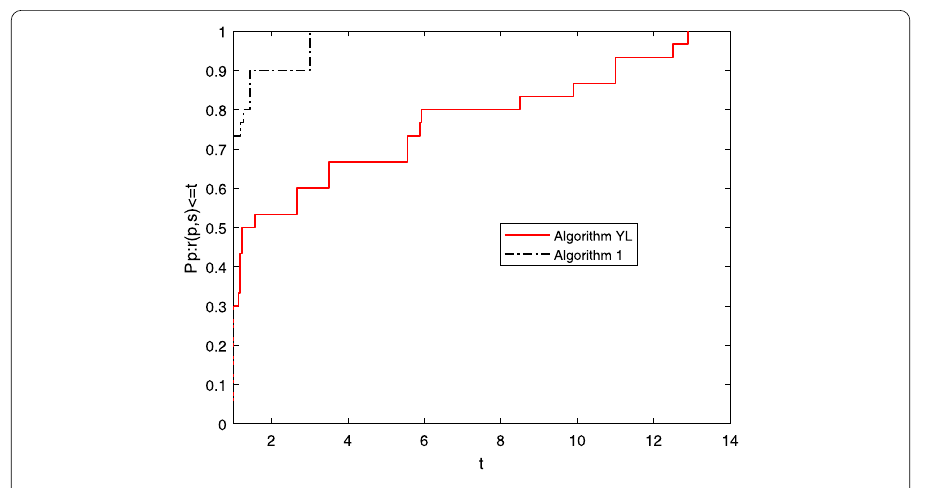
Figure 2 Performance profiles of these methods (NG)